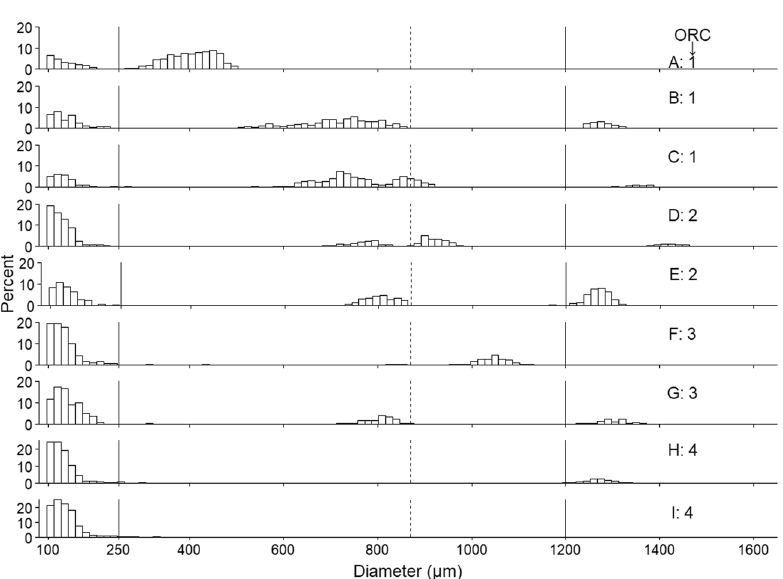
Figure 2. Representative OSFDs belonging to each of the four ORCs. OSFDs from pre-spawning ( A ), early- spawning ( B,C ), mid-spawning ( D,E ), late-spawning ( F,G ), very late-spawning ( H ), and post-spawning fish (I ). Other details as for Fig.